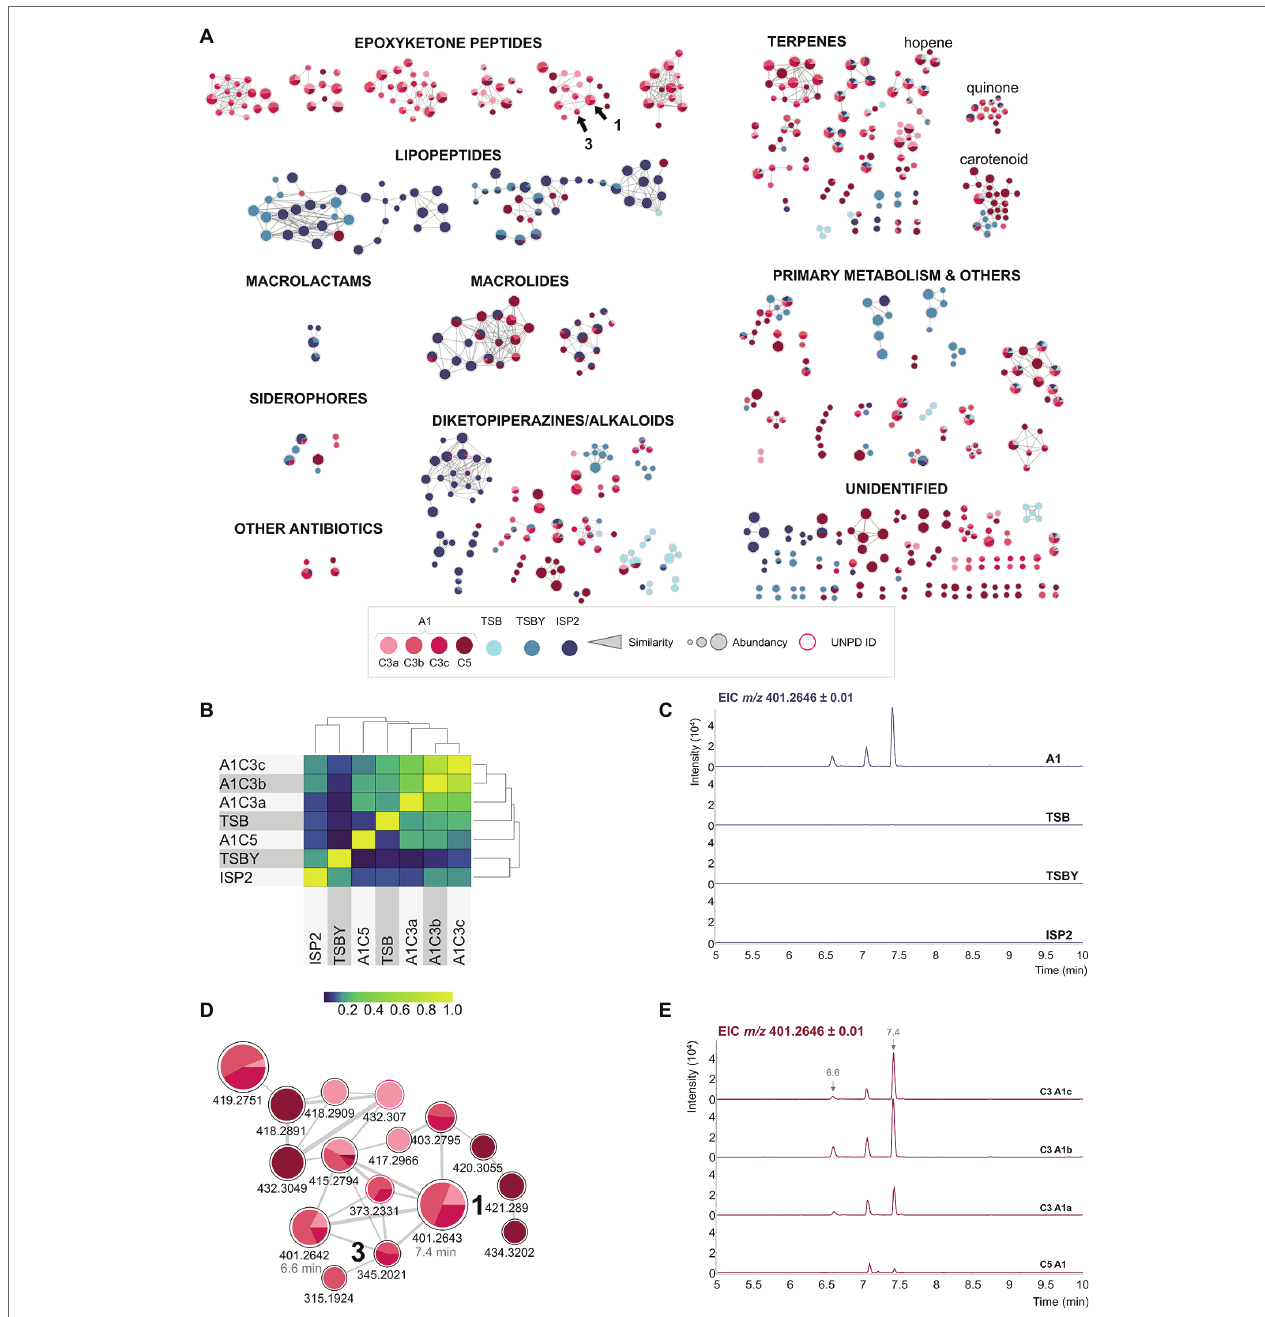
FIGURE 2 | The biosynthesis of BRA-346 secondary metabolites is tightly regulated by the culture media used for bacteria growth. (A) Spectra similarity molecular network (SSMN) of the different BRA-346 cultures media A1 (cultures C3a–c and C5, in red tones), TSB (cyan), TSBY (light blue), or ISP2 (dark blue). MS/MS spectra detected in the crude extracts are shown as the network nodes. For clarity, only the MS/MS spectra pointed as the protonated ion ([M + H] + ) and nodes with at least one connection (self-loops and single nodes were removed) are shown. The MS/MS spectra were annotated by spectra matches with UNPD-ISDB and GNPS databases, visually inspected and compared to literature data. Chemical classes were annotated, and the MS/MS clusters grouped accordantly. The annotated chemical classes could also be linked to the Streptomyces sp. BRA-346 draft genome. DHE (1) and DH-TMC (3) are pointed by arrows. The MS/MS annotations for 1 and 3 were based on the described by Furtado et al. (2021) and Zabala et al. (2016), respectively. The parameter used for node size was intensity value ([minimum value; 100,000]: linear interpolation, [100,000; maximum value]: constant size). (B) Heat map constructed from all nodes detected in the SSMN shown in (A), considering the seven BRA-346 cultures analysed. The MS1 peak area was normalized by the maximum area of a given m/z and used for a cosine similarity analysis of the detection of each node across the different cultures. (C) Extracted ion chromatogram (EIC) of m/z 401.26 ± 0.01 in BRA-346 cultures with the different media used. The region 5–10 min (“x” axis) was selected for clarity. (D) Detail of the epoxyketone peptide MS/MS cluster extracted from the SSMN shown in (A) . (E) EIC of m/z 401.26 ± 0.01 in the four BRA-346 cultures in the A1